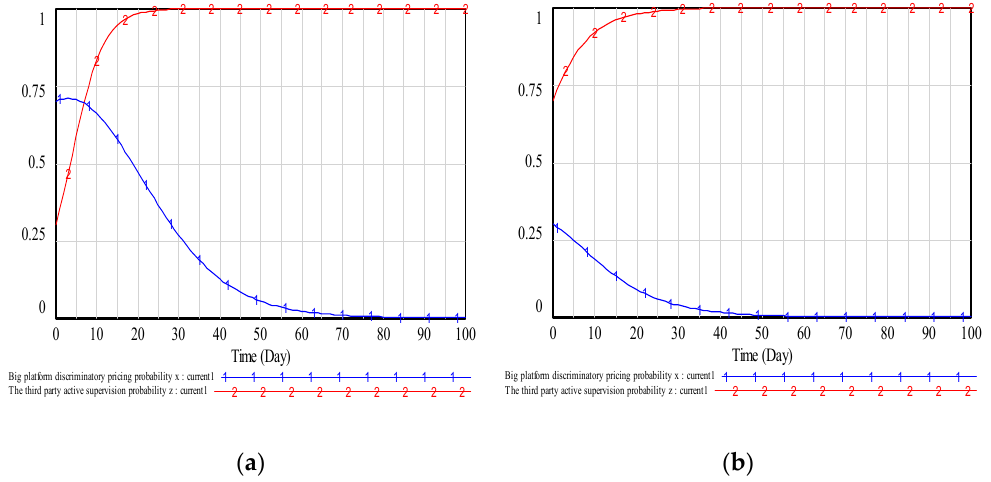
Figure 10. The evolution paths of stability point (0,1) . ( a ) The initial proportion pair of the big platform and the third party is (0.7,0.3) . ( b ) The initial proportion pair of the big platform and the third party is (0.3,0.7) .